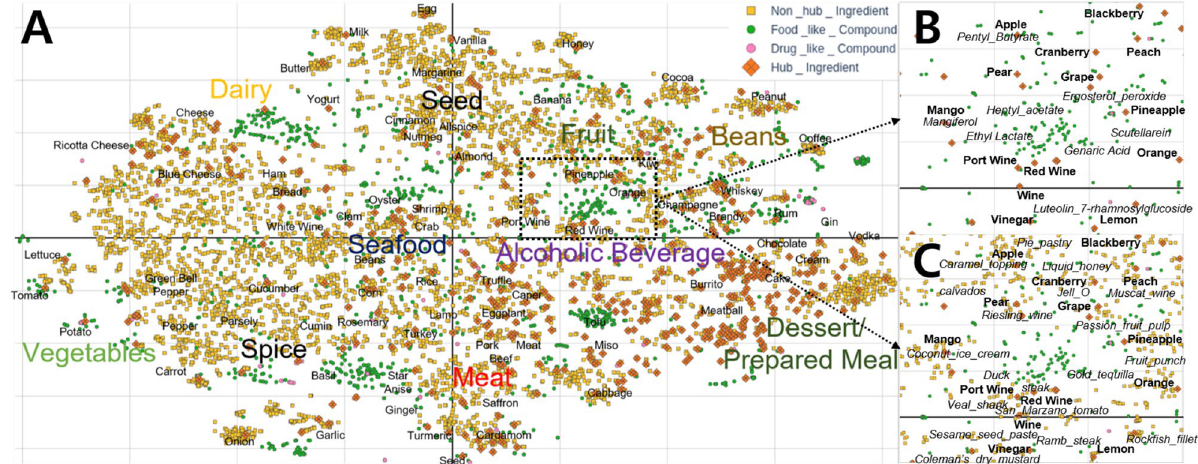
Figure 3. FlavorGraph node representation results. ( A ) 2D t-SNE projection of whole food ingredient nodes (6653) and chemical compound nodes (flavor compounds: 1561, drug compounds: 84) from FlavorGraph . ( B ) <chemical hub ingredient-compound relation>. This figure shows the chemical compounds shared by wines and citrus fruits (orange, pineapple, grape, cranberry) and how they affect their overall taste. ( C ) <chemical hub ingredient-non hub ingredient>. This figure shows which common foods go well with certain wines and citrus